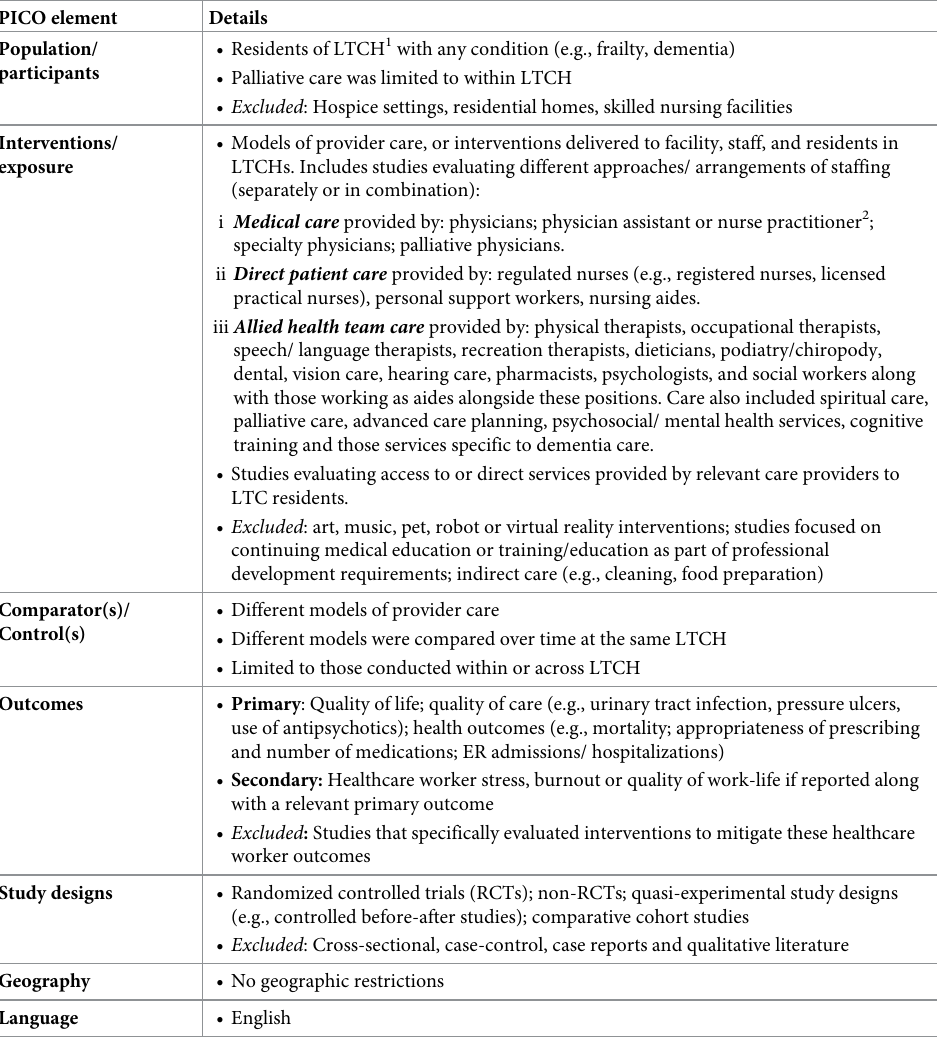
Table 1. Inclusion/exclusion